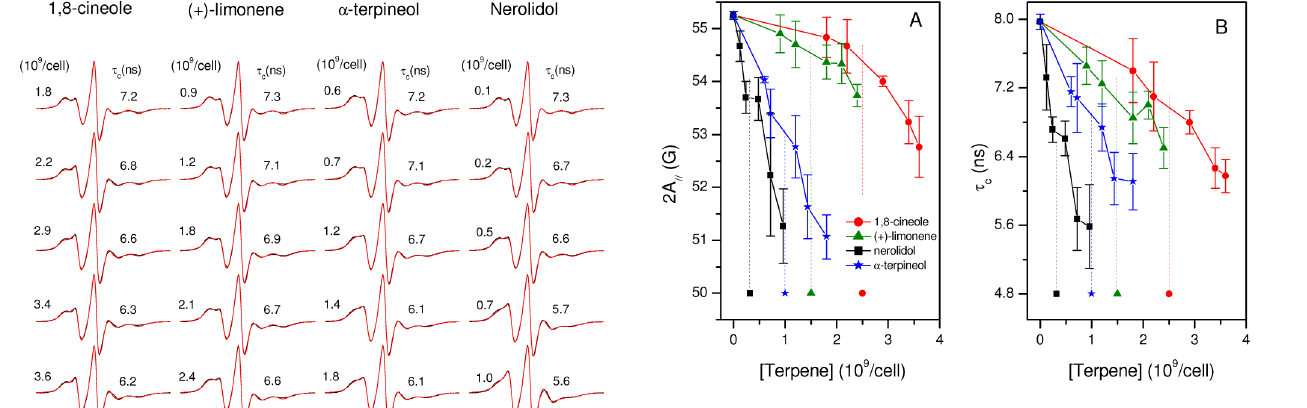
Figure 5. Effect of terpenes on the dynamics of the Leishmania plasma membrane. EPR parameters 2A // (panel A) and rotational correlation time, t c , (panel B) of the spin label 5-DSA in the membranes of Leishmania amazonensis promastigotes as a function of the terpene concentration used in the treatment. The IC 50 values of the terpenes are represented by single points at the bottom of each curve and dotted lines. The estimated experimental errors for 2A // and t c are 0.5 G and 0.2 ns, respectively.